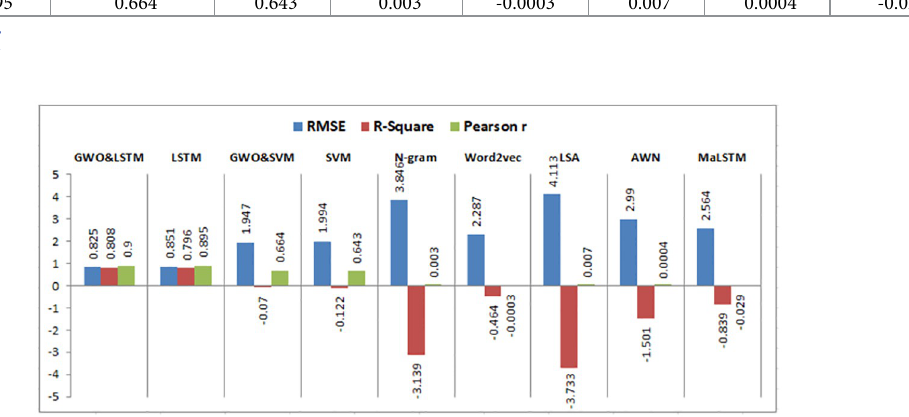
Fig 25. LSTM-GWO performance evaluation with experiment 3.